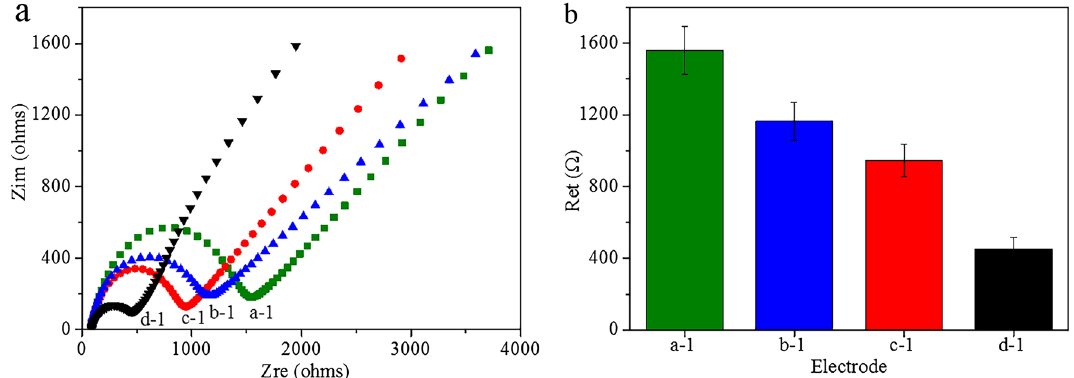
Figure 2. ( a ) Nyquist plots and ( b ) semicircle diameters from EIS characterization of electrodes modified with different materials in 0.01 M PBS (pH = 7.0) containing 5 mM [Fe(CN) 6 ] 3−/4− and 0.1 M KCl: (a-1) GE, (b-1)